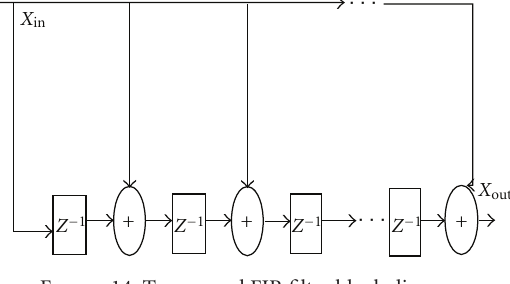
Figure 14: Transposed FIR filter block diagram.